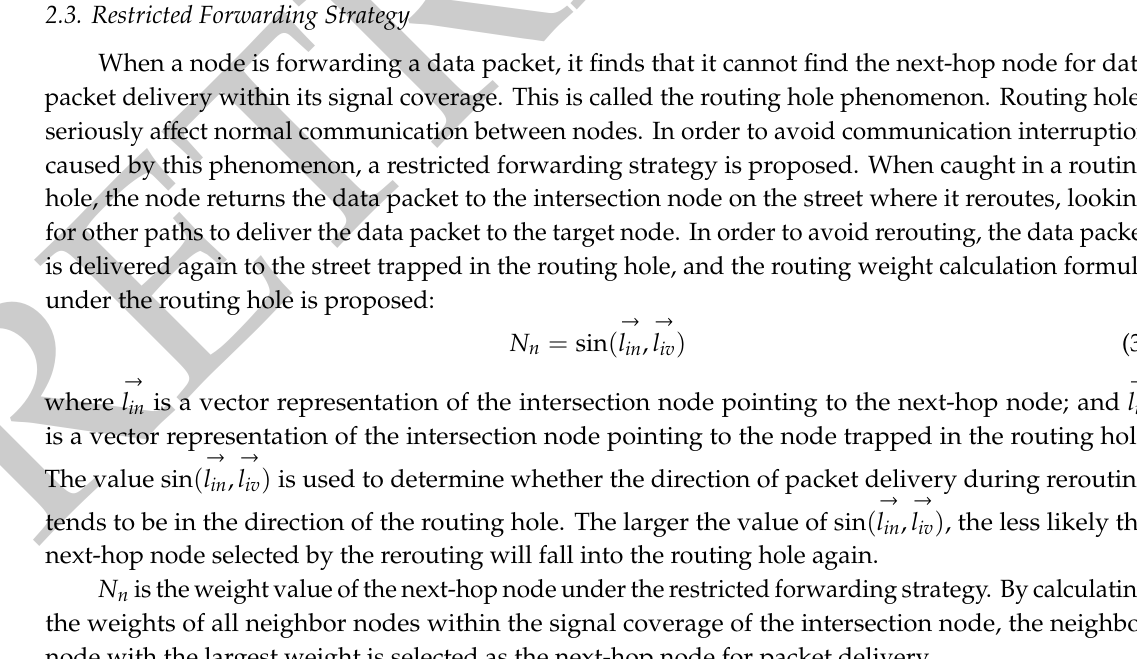
Figure 4. Schematic diagram of the repair strategy for weight selection.